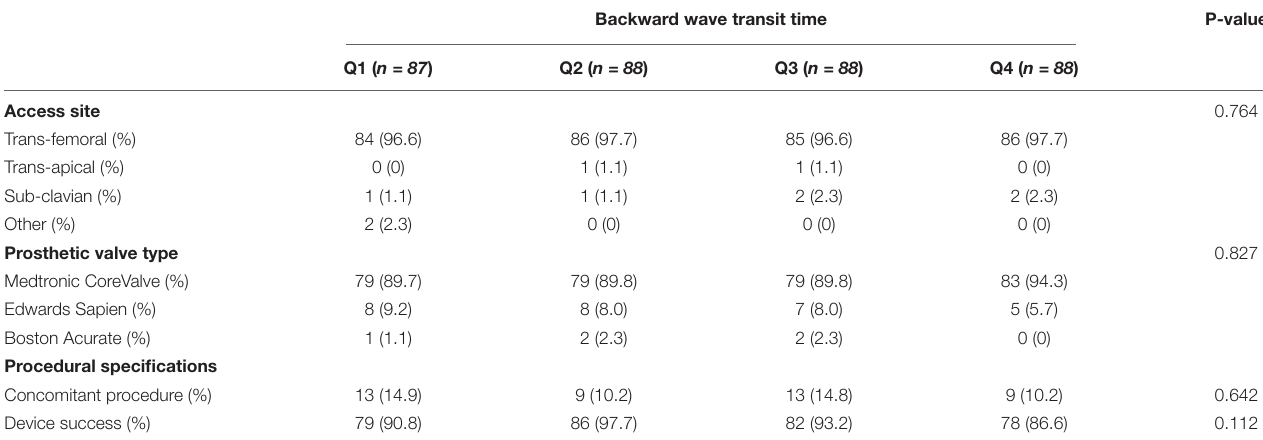
TABLE 4 | Transcatheter aortic valve replacement (TAVR) procedural characteristics.